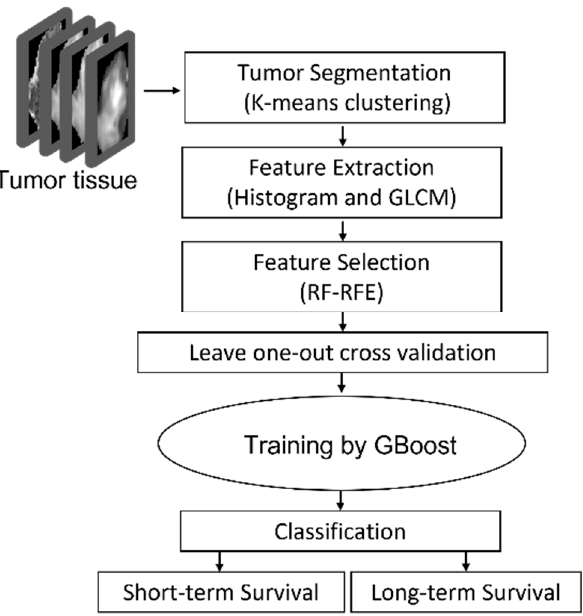
Figure 1. GBMs survival prediction model outline using RF ‐ RFE GBoost machine.